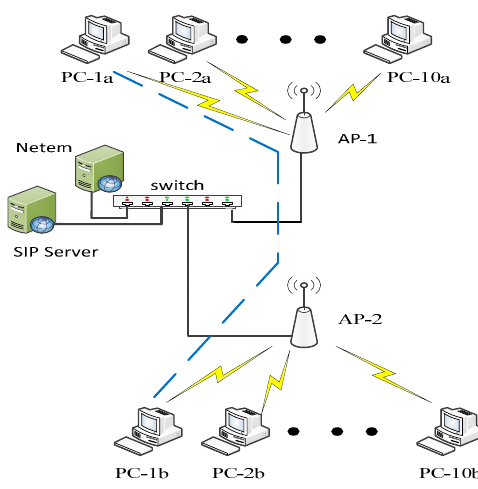
Figure 3. The network topology used in the study.